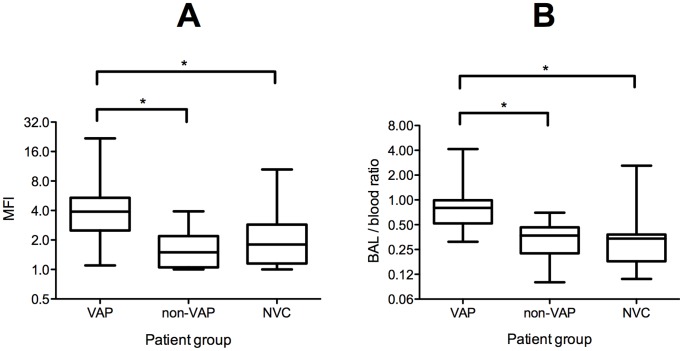
BALF levels and BALF/blood ratios of monocytic TREM-1.Box (interquartile) and whisker (range) plots showing expression of TREM-1 by CD14+ monocytes in BALF (Figure 1a) and the BALF/blood ratio of TREM-1 expression by monocytes in blood and BALF (Figure 1b) from patients with VAP, non-VAP (ventilated non-pulmonary infected control) and NVC (non-ventilated control). BALF levels were corrected for dilution occurring with bronchoscopy using urea measurement. Statistically significant differences between groups were determined using the Mann-Whitney U and post hoc Dunn correction as follows: monocyte TREM-1 levels for VAP versus non-VAP and NVC (p<0.001)* and BALF/blood monocytic TREM-1 ratio VAP versus non-VAP and NVC (p<0.001)*. MFI = mean fluorescence intensity.